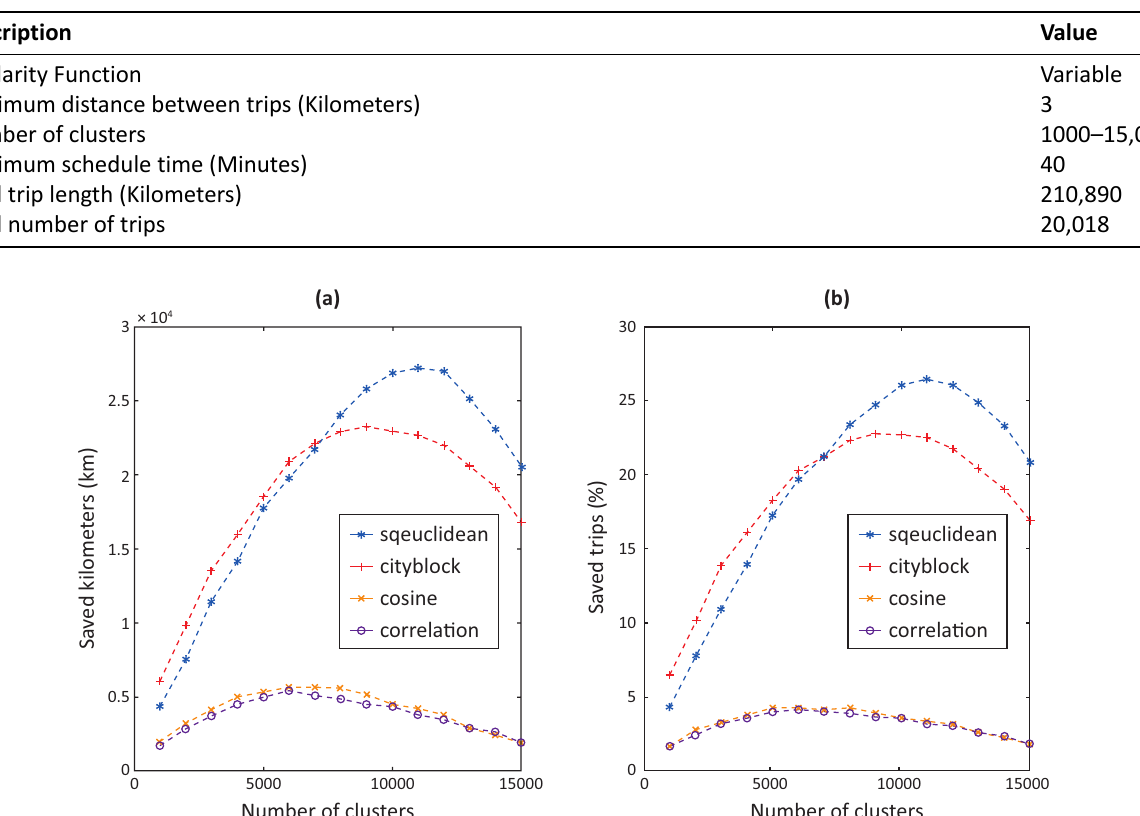
Table 3. Simulation set up parameters (case study 3)